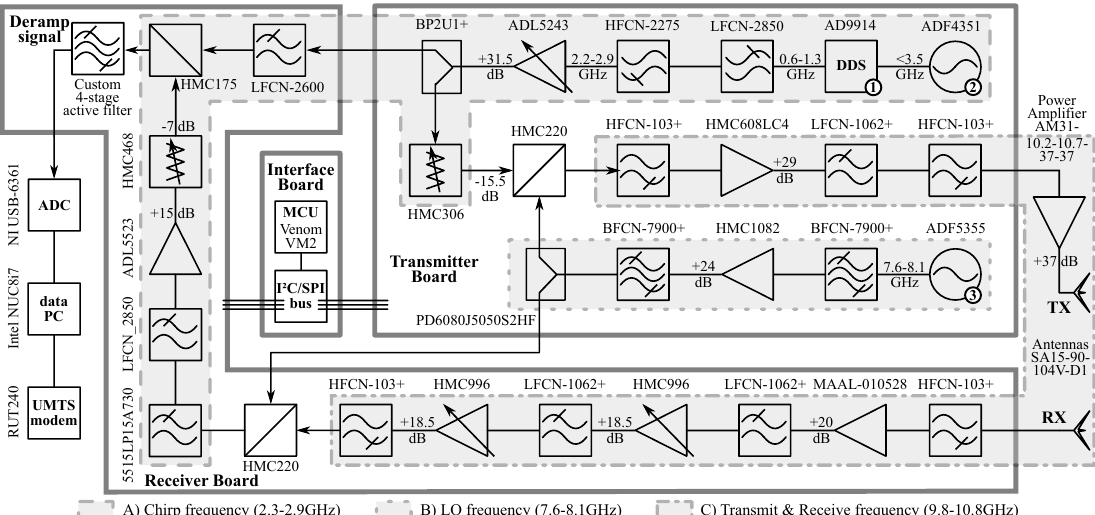
Figure 1. Hardware schematic with high-frequency components, data acquisition and controlling devices of radar mGEODAR. Three printed circuit boards (PCB) boards host the radar hardware: The transmitter board is shown on top-right, the receiver board is on the bottom-left and the interface board for control of HF components is in the middle. The data acquisition, storage and processing devices are shown on the far left. Signal generator and oscillators are enumerated (no. 1–3). Annotation with light gray boxes and letters (annot. A–C) indicate areas with same frequency. The frequency responses of all filters in these boxes are drawn in Figure